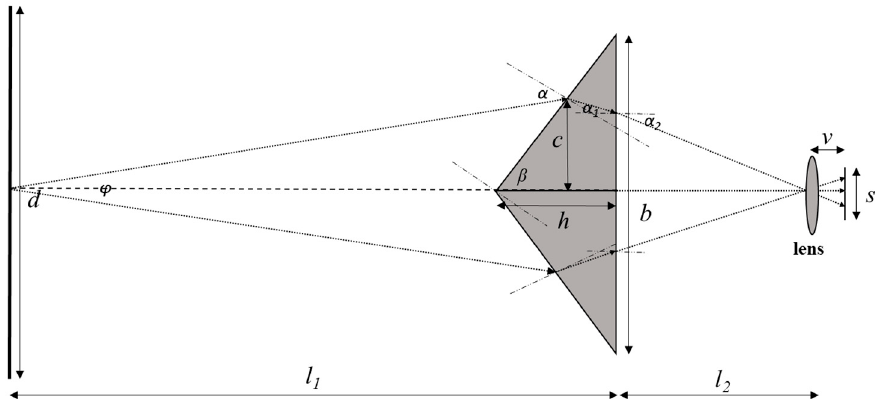
Figure 8. The geometric optical path diagram of the pyramidal prism. Further, the distance between the prism and the lens set and the distance between the prism and the object set can also be roughly calculated according to Equations (7) and (8),